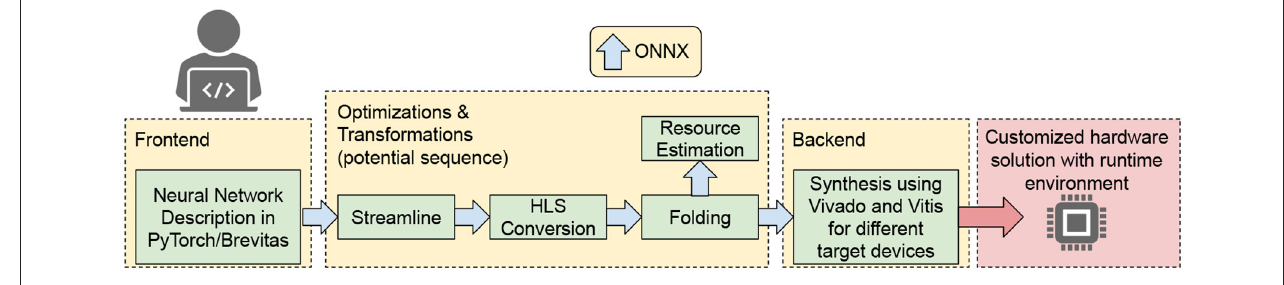
FIGURE 9 | FINN compiler